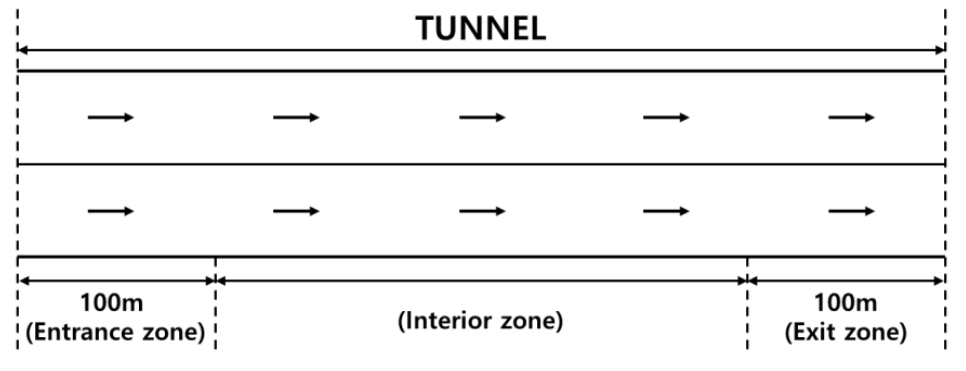
Figure 1. Sub-divided tunnel zones.